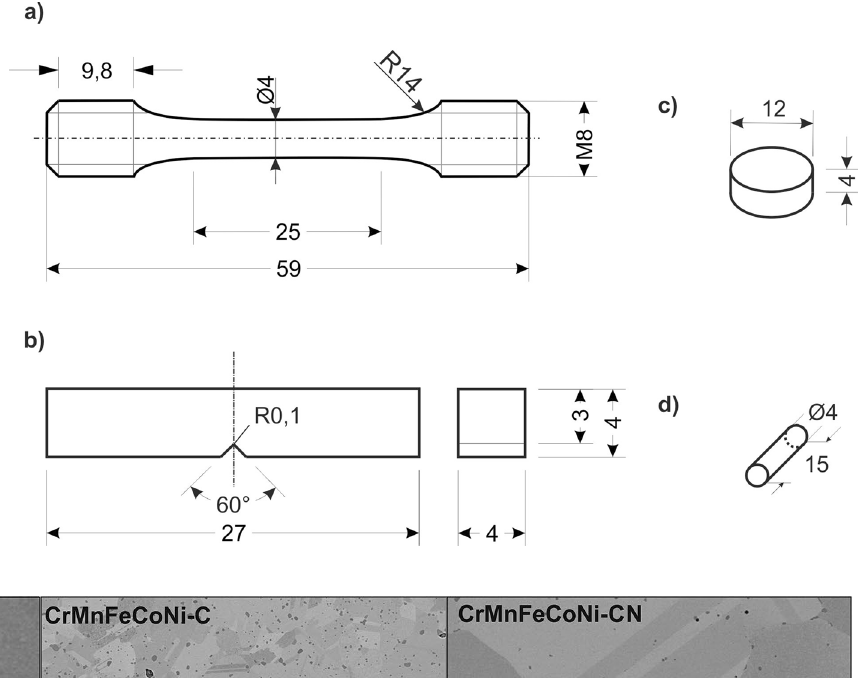
Fig. 1 Schematic representa- tion of the specimens used in this investigation. a Tensile test, b Impact test, c Ball and disc wear test, d Pin abrasion test